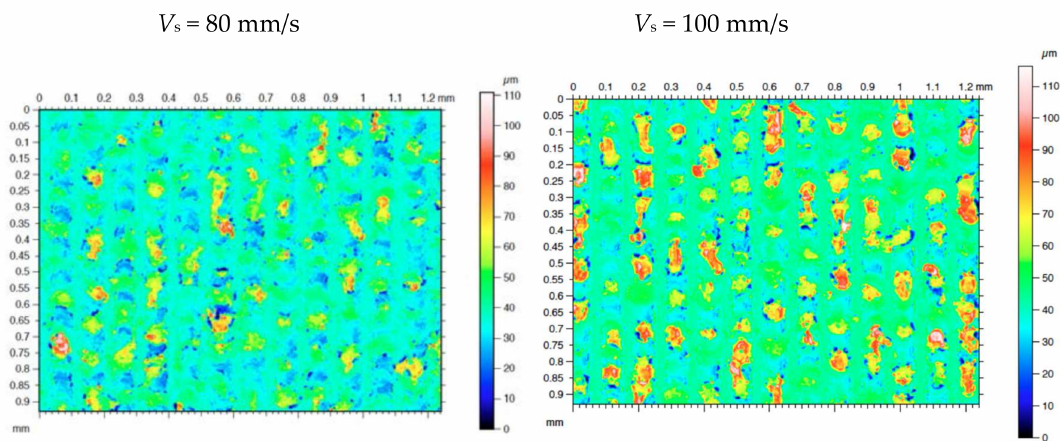
Figure 10. Topographic evolution of the textured layer for the S-II speed set, which has intermediate scanning speeds ( V s = 80 mm/s to V s = 100